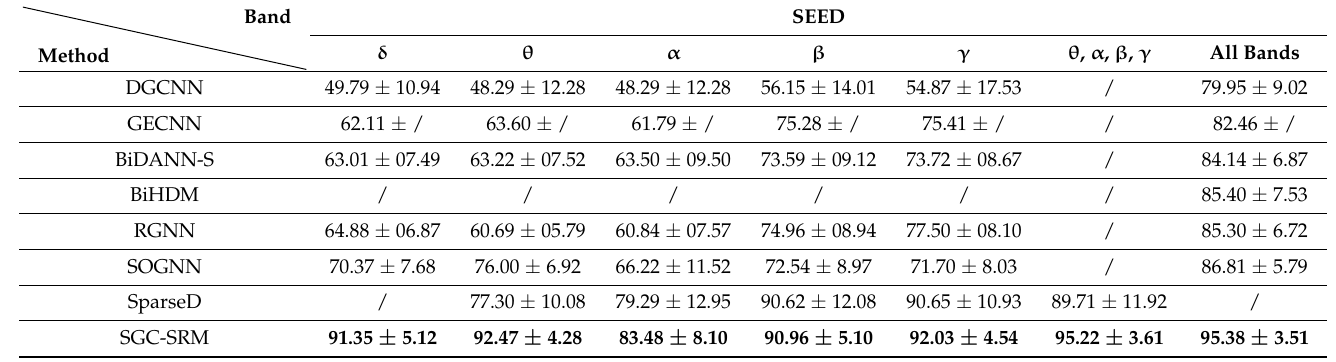
Table 3. Leave-one-subject-out emotion recognition accuracy (mean ± standard deviation) on